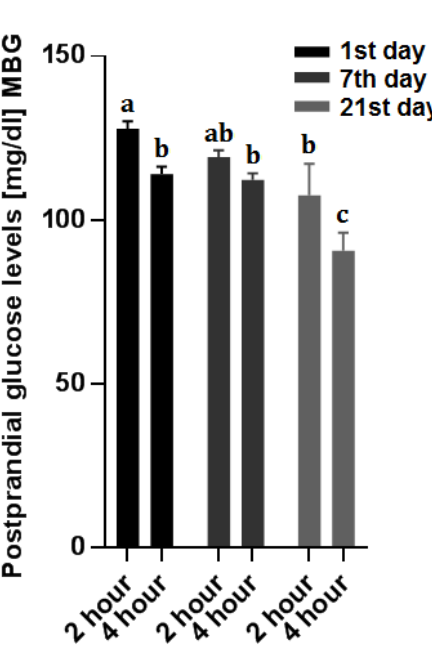
Figure 1. The effect o f Ballota extract on postprandial glucose level (Mean±SD) in normal mice (Gro up